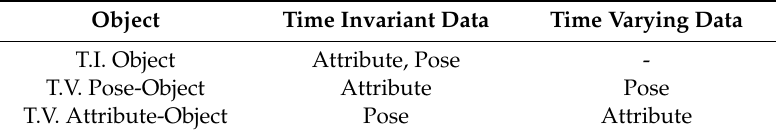
Table 1. Data of object type.